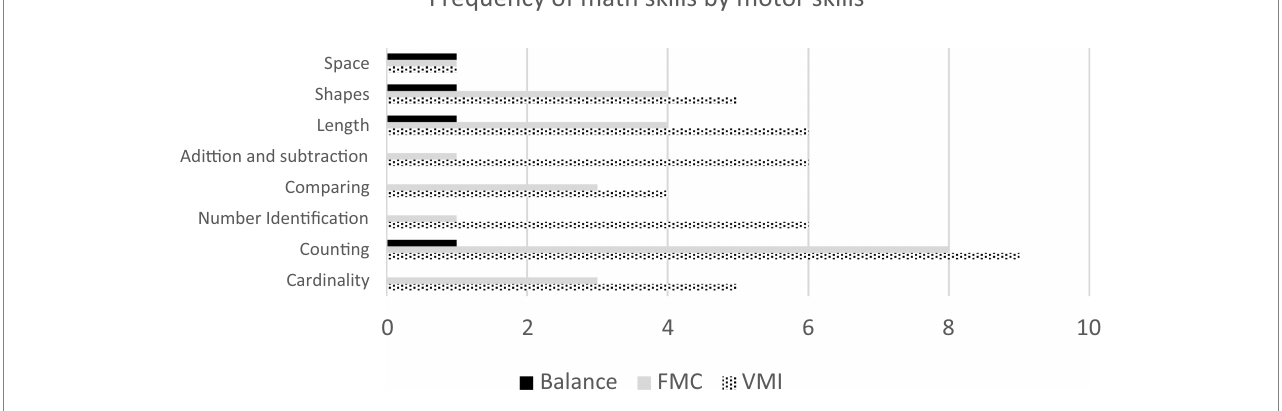
FIGURE 5 Distribution of studies associating FMS (FMC and VMI) and balance with math skills. FMC, fine motor coordination; VMI, visuomotor